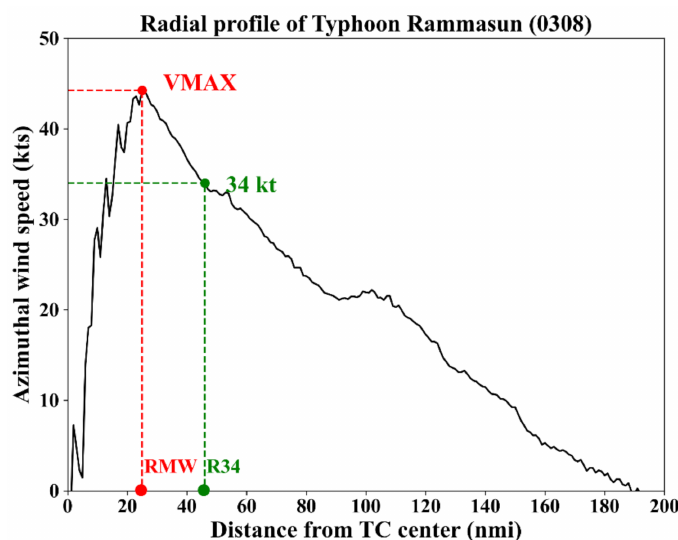
Figure 2. Schematic diagram of the radius of maximum wind (RMW; dashed red line) and 34 kt wind (R34; dashed green line) of Typhoon Rammasun (0308). The radial profile was obtained from QuikSCAT at 20:42 UTC on 9 May 2008. VMAX represents the maximum wind speed. At TC warning centers, the wind speed and distances from the TC center (including the RMW and R34) are reported in knots (1 kt = 0.514 m s − 1 ) and nautical miles (1 nmi = 0.185 km), respectively. For this reason, these operational units are used exclusively